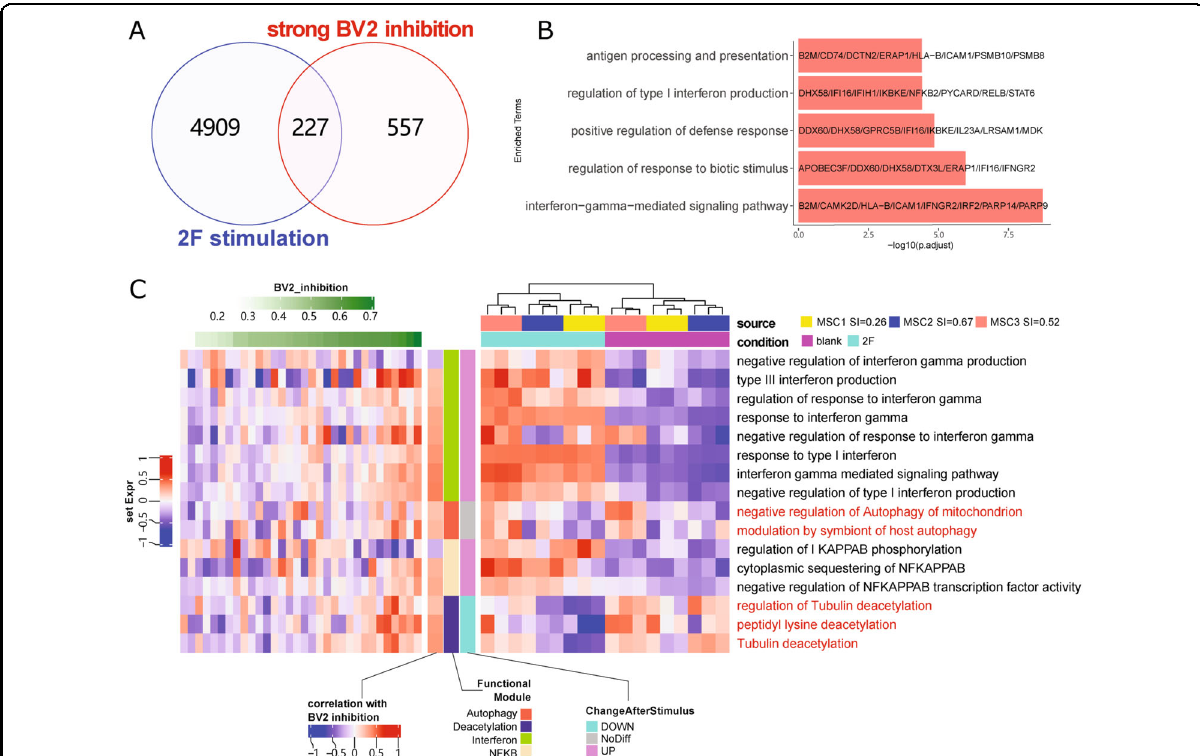
Fig. 6 Two transcriptomic data sets (32 huMSC lines and 3 huMSC lines with and without 2-factor stimulation) revealed common genes and pathways. A Venn diagram shows the overlap between genes up-regulated by 2-factor stimulation and genes positively correlated to BV2 inhibition capacity. B GO enrichment analysis of overlapped 227 genes. C GSVA heatmap shows speci fi c GO-term associated gene sets in 32 huMSCs that positively or negatively correlated with BV2-cell immune suppressive capacity, and their expression levels before and after 2-factor stimulation. Results clearly indicated that interferon and NF- κ B pathway associated genes were upregulated upon 2-factor stimulation, whereas genes related to autophagy and protein deacetylation did not correlate well with 2-factor